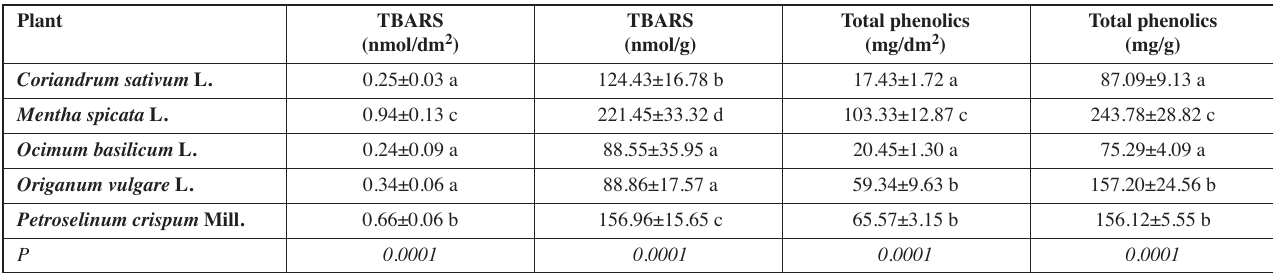
Tab. 4: Total thiobarbituric acid reactive substances concentration (TBARS) and total phenolic content (mg/g or mg/dm 2 of fresh weight) of leaves of the five studied species of medicinal and aromatic plants (mean ± SD, n =